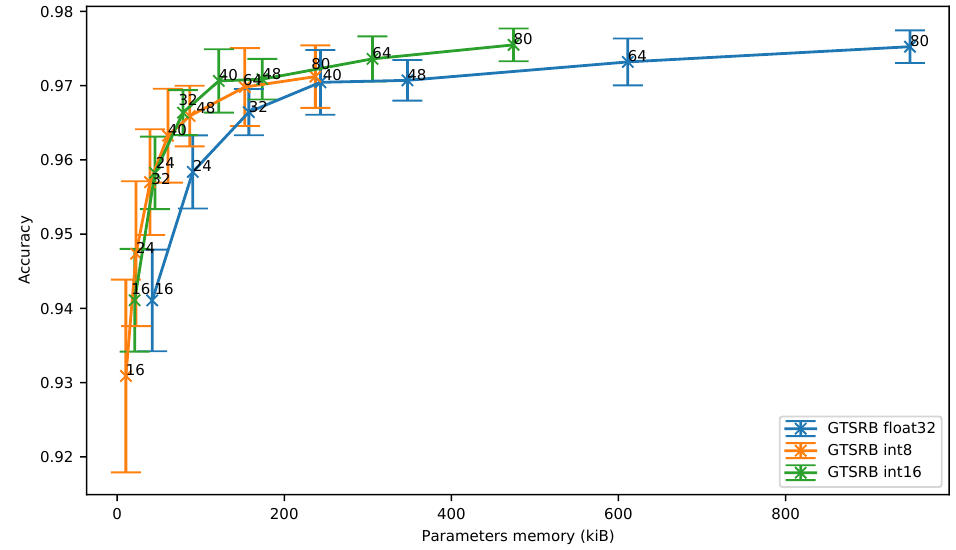
Figure 10. German Traffic Sign Recognition Benchmark: accuracy vs. parameters